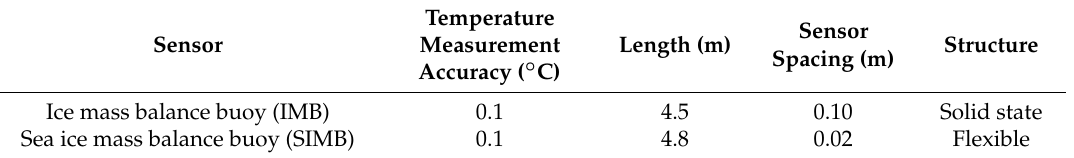
Table 1. States of the art in sea ice temperature